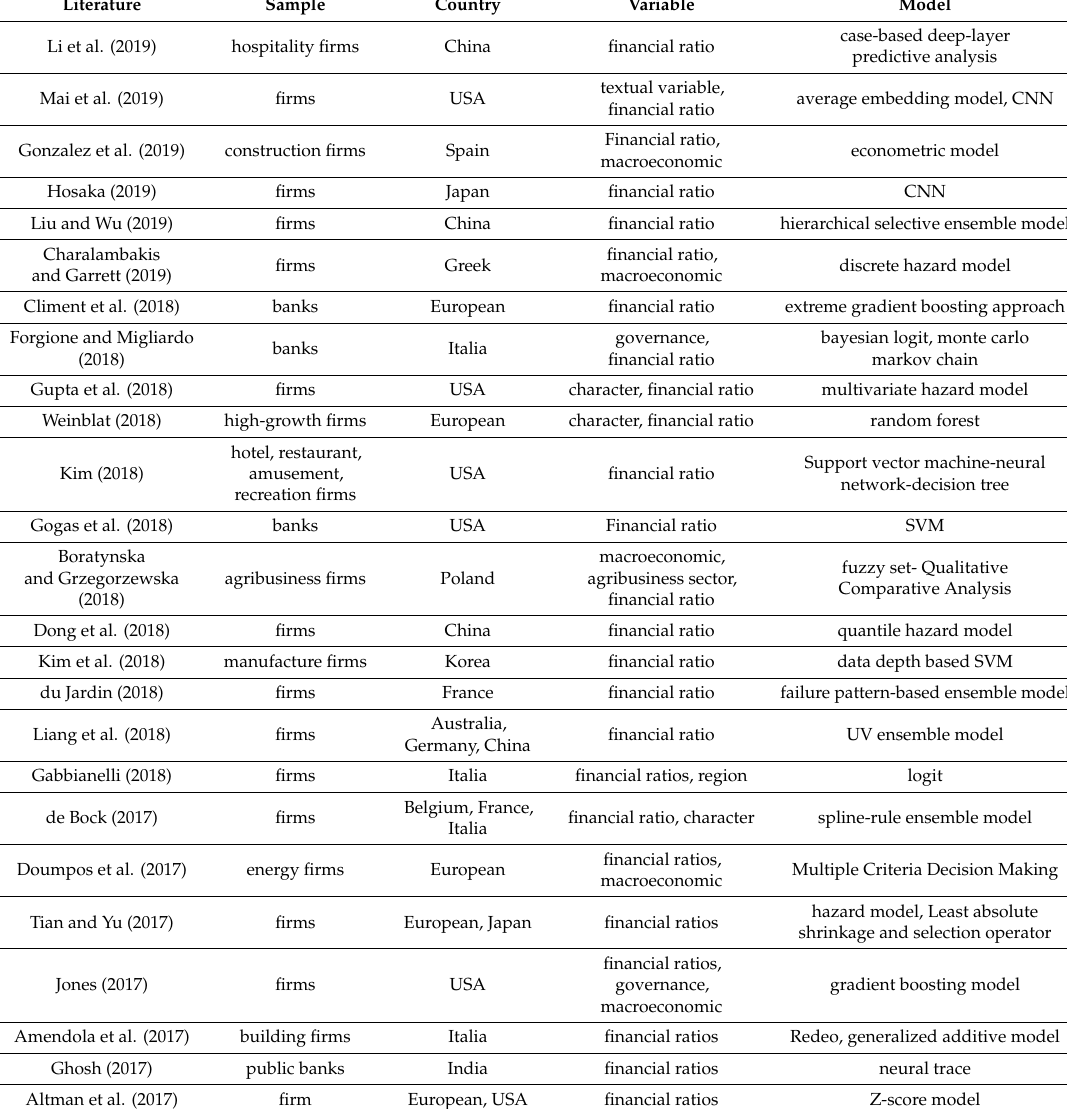
Table A1. Recent literatures of corporate failure